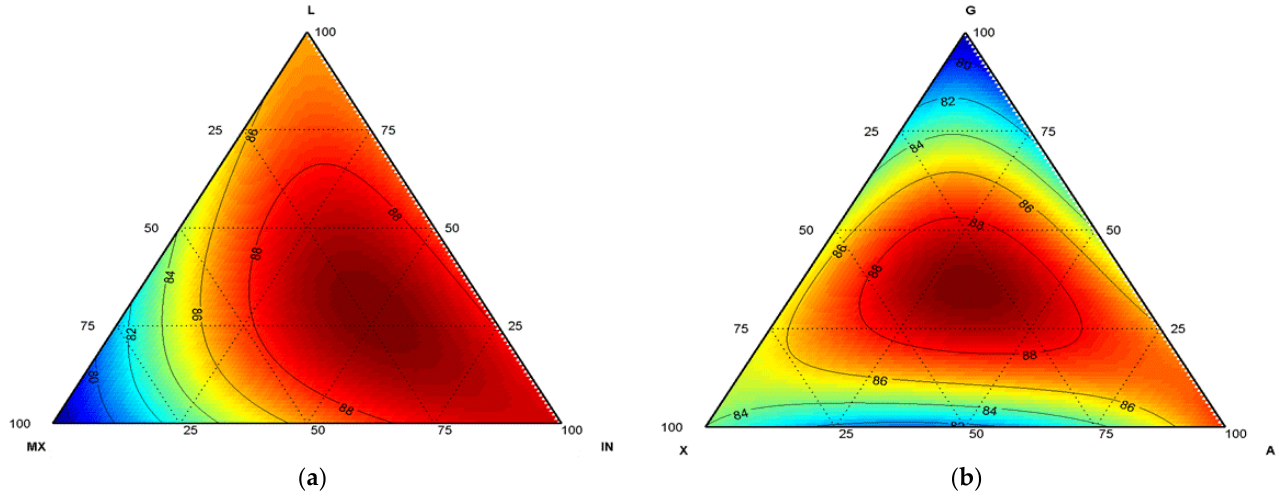
Figure 1. Yield surface graphic: ( a ) matrix I, IN:L:MX; ( b ) matrix II, A:G:X.